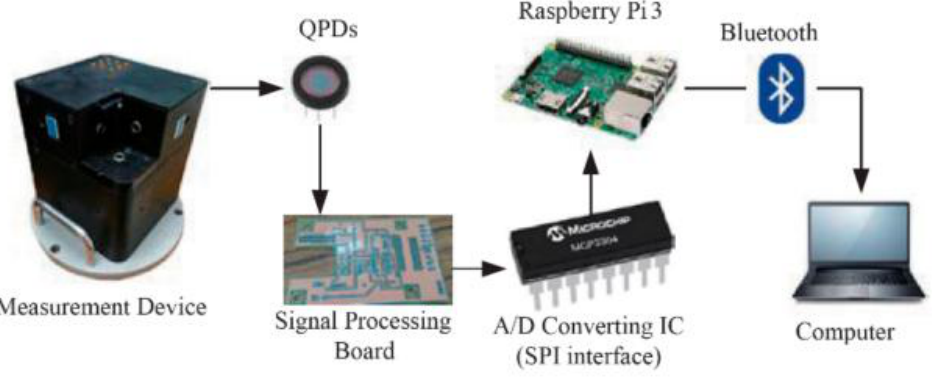
Figure 40. Signal processing schematic with measurement device